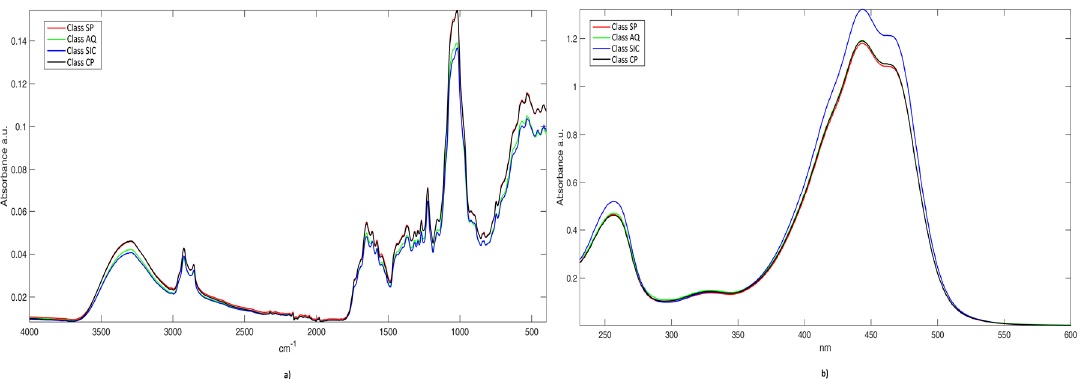
Figure 1. Mean raw spectra per class. a ) IR signals; and, b ) UV-Vis signals.